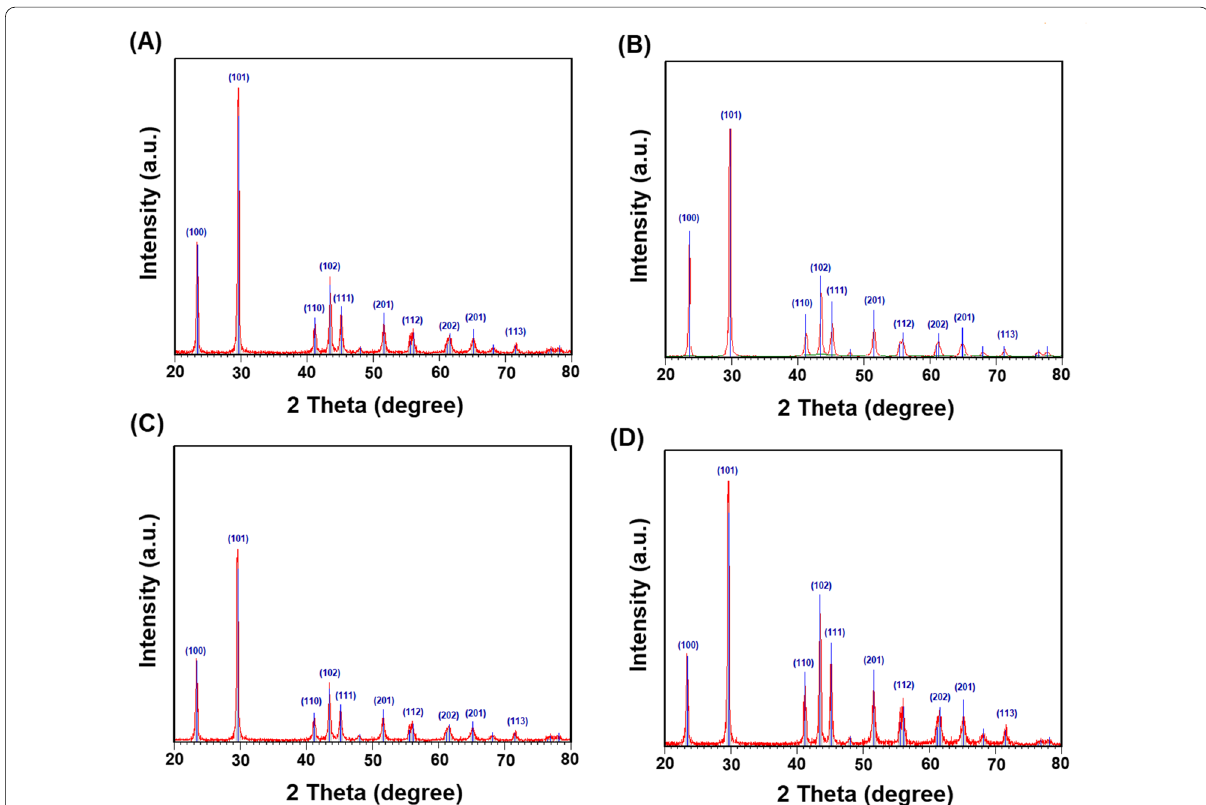
Fig. 3 X‑ray diffraction patterns (Cu Kα‑radiation) of SeNPs at room temperature. A XRD pattern of SeNPs synthesized by A. quadrilineatus , B XRD pattern of SeNPs synthesized by A. ochraceus , C XRD pattern of SeNPs synthesized by A. terreus , and D XRD pattern of SeNPs synthesized by F. equiseti